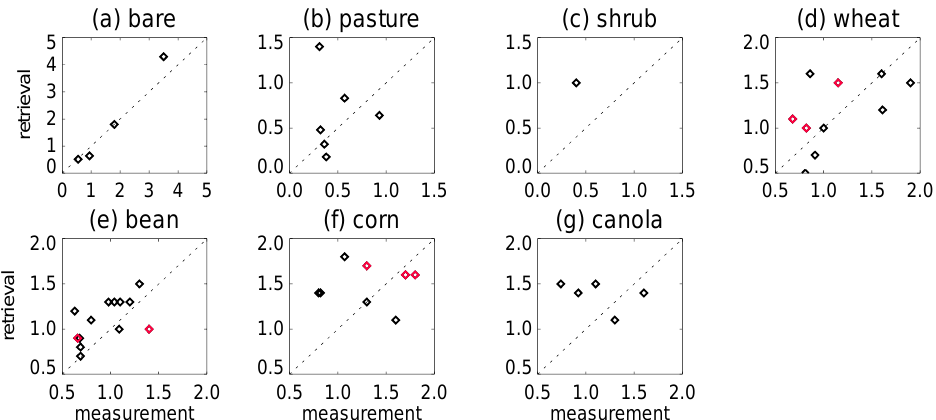
Figure 3. Validation of roughness retrievals (in cm) from the field campaigns ( a ) bare surface of Michigan Tower [22]; ( b ) SGP99; ( c ) SJV (only one datum); ( d – g ) SMAPVEX12. Each datum represents one time-invariant estimate of roughness using time-series observations of σ 0 at individual spatial fields. Colored in red in ( d – f ) are associated with the presence of observed exit periodic row structure of vegetation. The quantitative values are shown in Table 2. Table 3. Surface roughness retrieval in cm using 3-km SMAP data. Mean and standard deviation of the